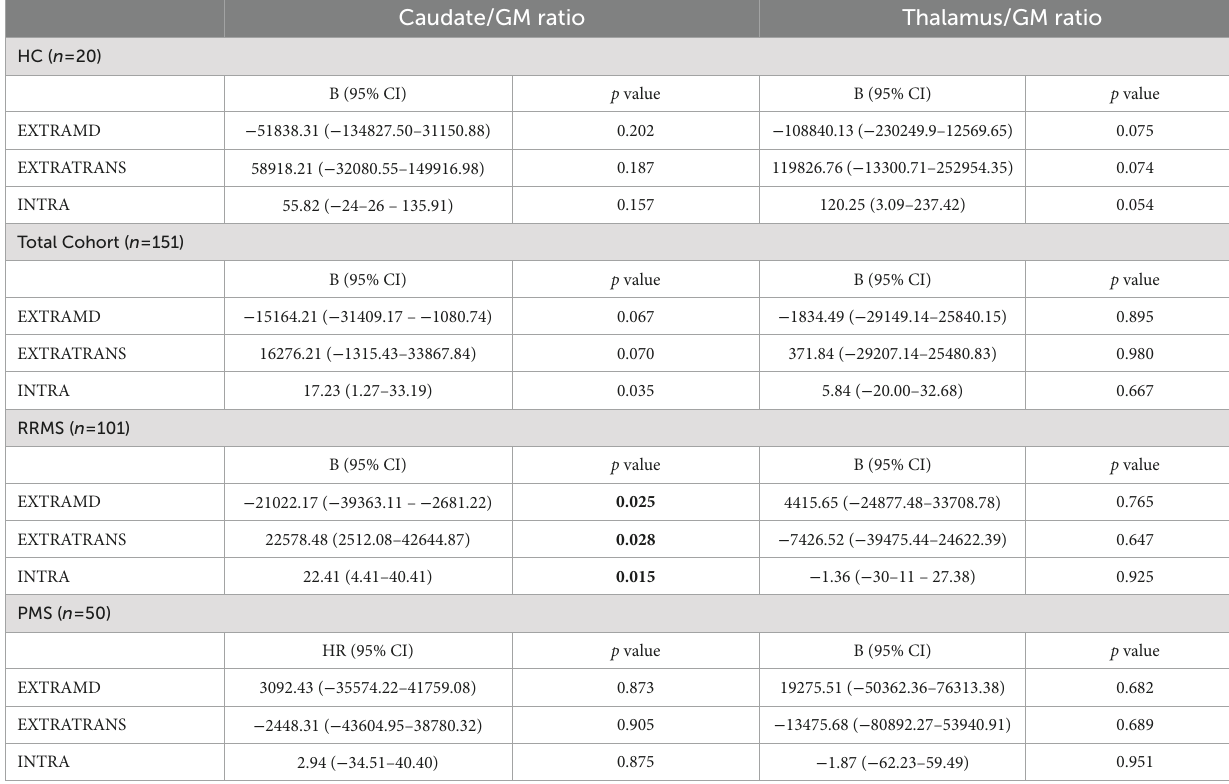
TABLE 3 Multivariate analyses exploring the association between NA-SVZ microstructural properties and caudate and thalamus GM ratio.